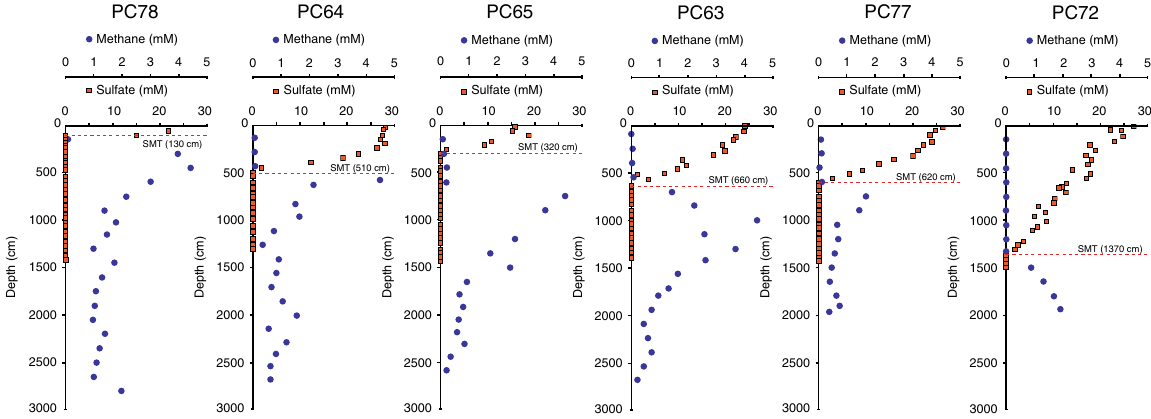
Fig. 5 Methane and sulfate concentrations in pore waters. A transect across the edge of the hydrate stability zone with six piston cores (PC) showing methane and sulfate concentration in pore waters (location in Fig. 1). The depth of the sulfate − methane transition (SMT) is indicated in each pro fi le with a dashed orange line, drawn at the depth of no